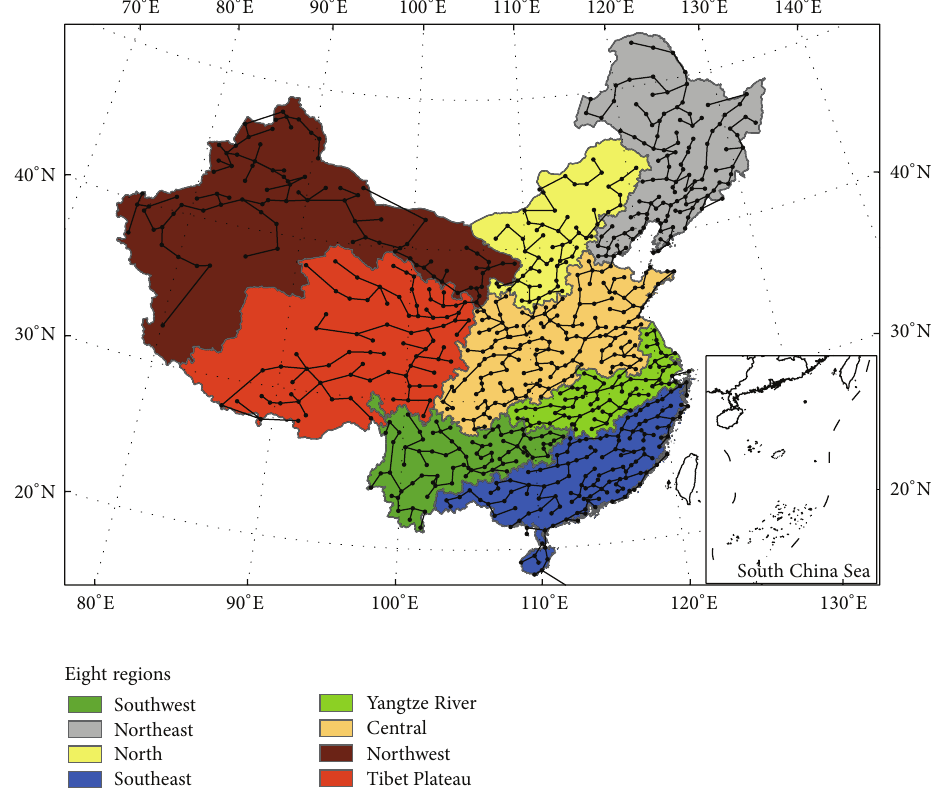
Figure 3: Locations of eight regions within China.